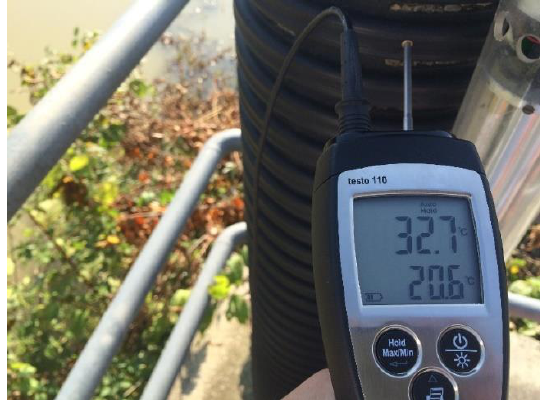
Figure 2. Temperatures measured on the sunny and shady side of the measurement pillar.